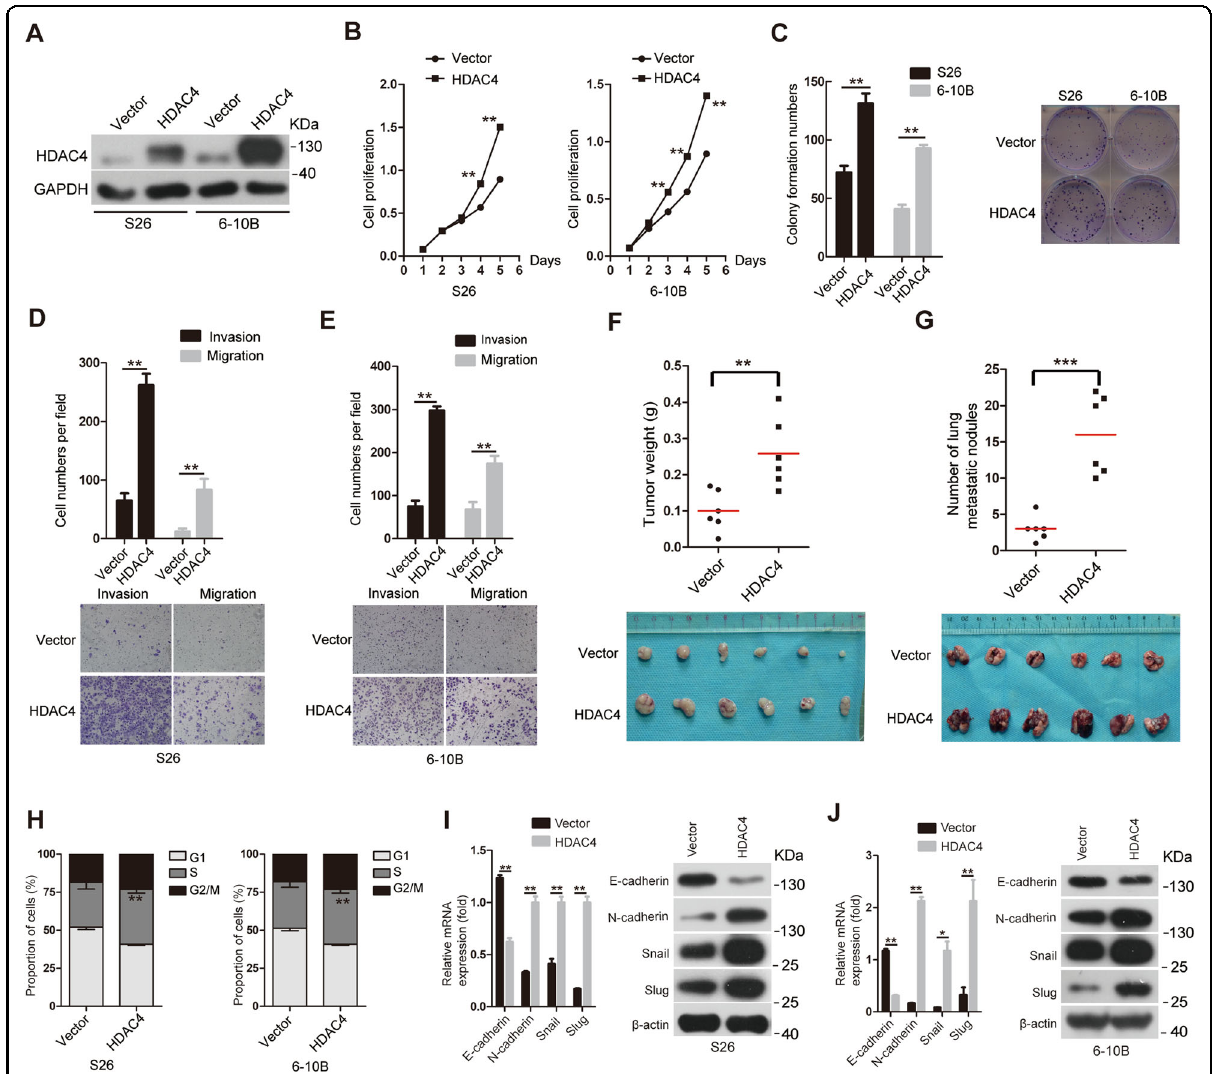
Fig. 2 Overexpression of HDAC4 promotes tumor growth and metastasis in NPC. A The protein expression levels of HDAC4 were determined in S26 and 6-10B cell lines stably expressing vector or HDAC4 by western blotting. GAPDH was used as a loading control. B The proliferation of the indicated cells in vitro was determined by CCK8 assays. The data are presented as the means ± SD of three independent experiments. Student ’ s t -test, ** P < 0.01. C The colony formation ability of the indicated cells was determined. The images on the right are representative images. The data are presented as the means ± SD of three independent experiments. Student ’ s t -test, ** P < 0.01. D , E Cell migration and invasion were determined in the indicated cells as described in the “ Methods ” section. The images on the right are representative images in ( D ) and ( E ). The data are presented as the means ± SD of three independent experiments. Student ’ s t -test, ** P < 0.01. F The weight of orthotopic tumors after subcutaneous injection of 6-10B- vector and 6 - 10B HDAC4 cells. The data are presented as means ± SD. Student ’ s t -test, ** P < 0.01. n represents the number of nude mice in each group. G The number of metastases in the lungs of mice 8 weeks after the tail vein injection of 6-10B-vector or 6-10B HDAC4 cells. The data are presented as means ± SD. Student ’ s t -test, *** P < 0.001. n represents the number of nude mice in each group. H The cell cycle was investigated in S26-HDAC4 and 6-10B-HDAC4 cells by fl ow cytometry. The data are presented as the means ± SD of three independent experiments. Student ’ s t -test, ** P < 0.01. I, J The relative mRNA and protein levels of EMT-related genes were determined by qRT-PCR (left) and western blotting (right), respectively; GAPDH and β -actin were used as loading controls, respectively. The data are presented as the means ± SD of three independent experiments. Student ’ s t -test, * P < 0.05, ** P <